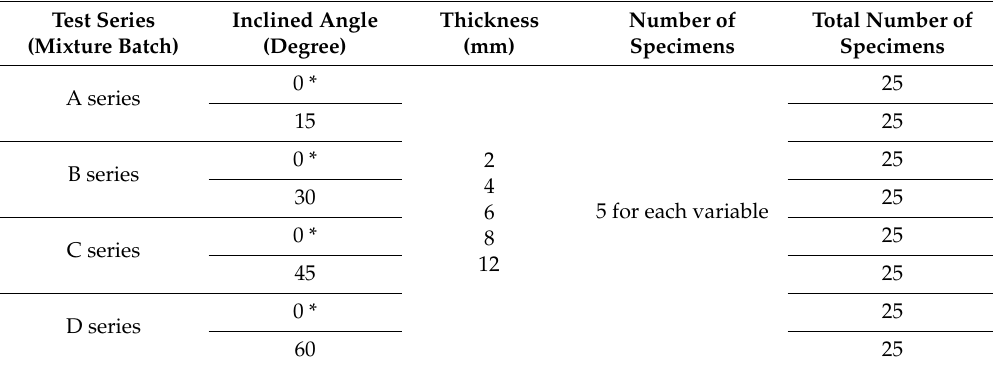
Table 1. Specimen list.